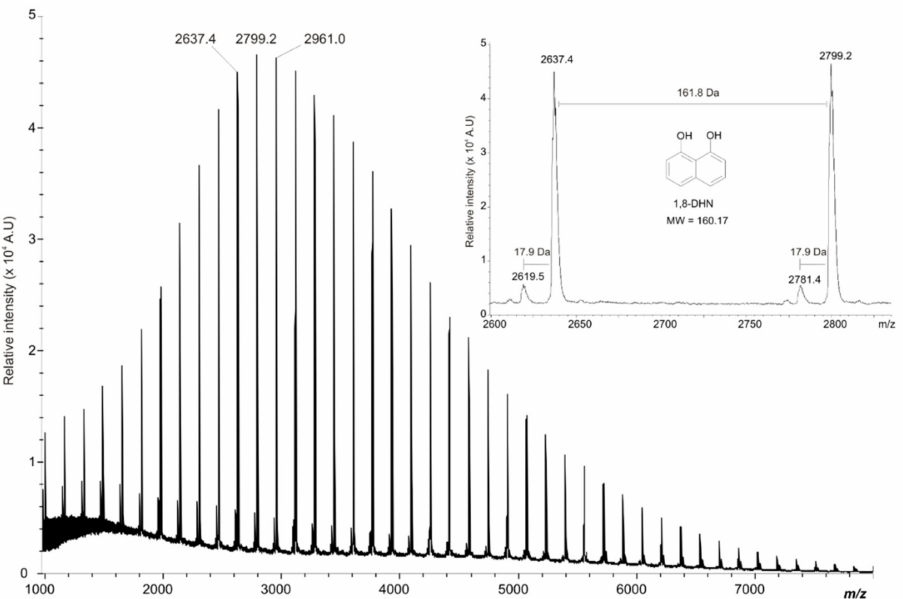
Figure 11. MALDI-TOF of DHN-melanin extracted from M. fijiensis mycelium. (Reproduced with permission from Ref.